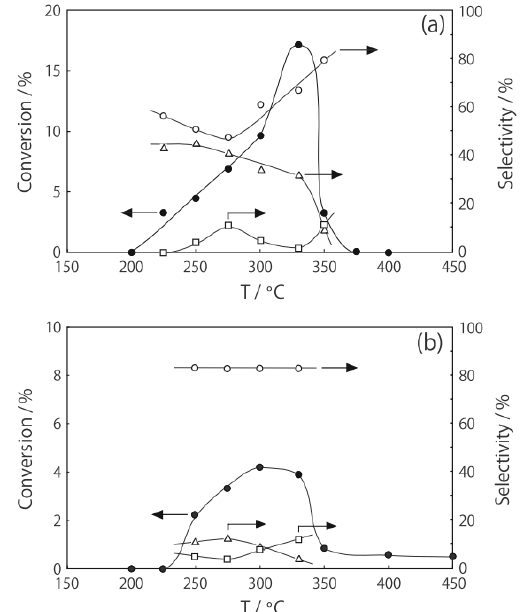
14. Effect of temperature on the dehydration of ethanol over ( a ) [(Nb Cl )Cl (H O) ]·4H O; and ( b ) (H 6 12 2 2 4 2